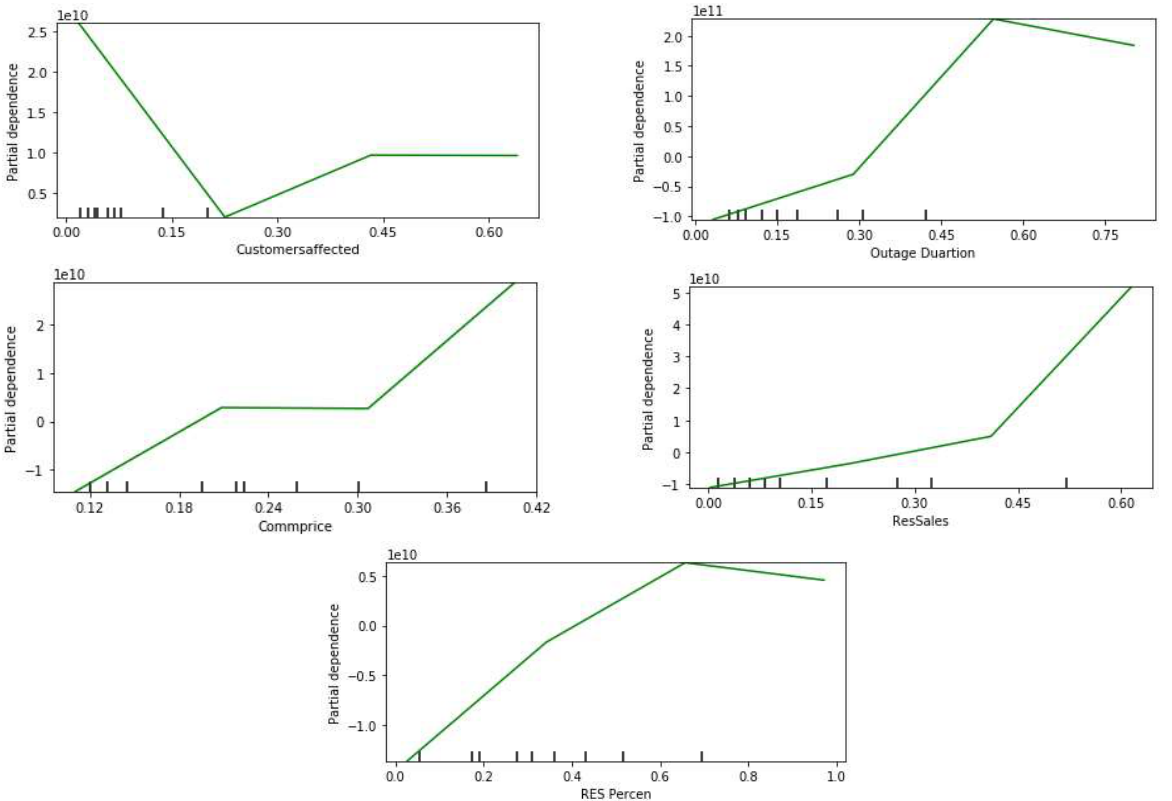
Figure 16. Partial dependency plots of top five important parameters for revenue loss prediction in the winter storm disaster category.